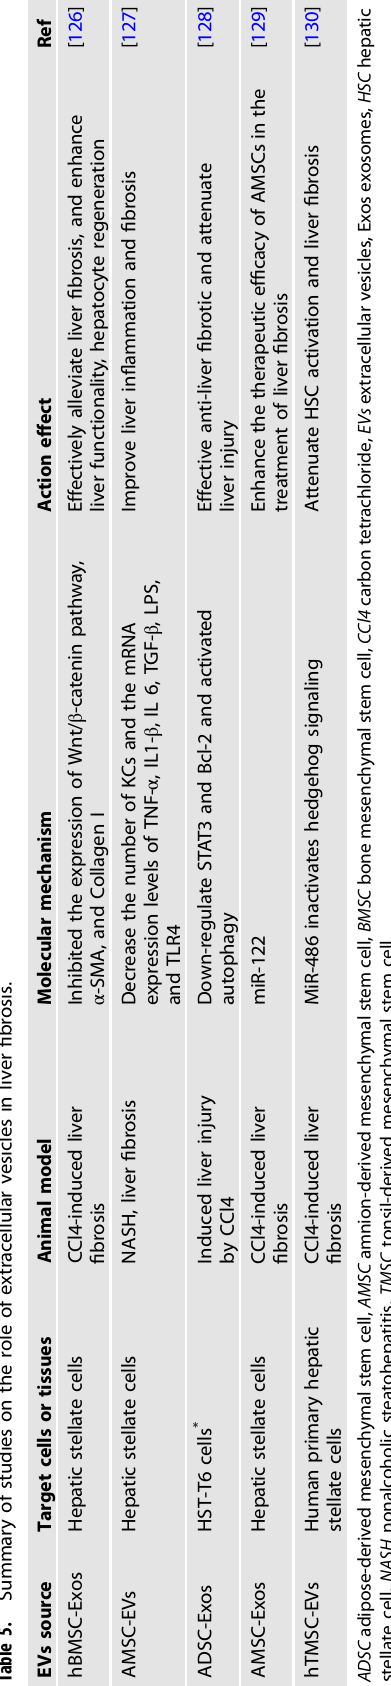
most tumors and is considered a tumor-like disease [142]. Recently, MSC-EVs have become an effective treatment for pulmonary fi brosis (Table 7). BMSC-Exos exert their therapeutic effect through immunomo- dulation. In a mouse model, BMSC-Exos have been shown to signi fi cantly ameliorate hyperoxia (HYRX)-induced bronchopul- monary dysplasia (BPD), alveolar fi brosis, and pulmonary vascular remodeling by suppressing M1 macrophage production and enhancing M2 macrophage generation [144]. Likewise, BMSC- Exos have been shown to signi fi cantly reverse fi brosis in a bleomycin-induced pulmonary fi brosis model by regulating total lung imbalance of M Φ phenotype [145]. In addition, the Wnt5a/ BMP signaling pathway regulated by UC-MSC-Exos can enhance Wnt5a, Wnt11, BMPR2, BMP4, and BMP9 expression, and down- regulate that of β -catenin, Cyclin D1 and TGF- β 1. In a monocrota- line (MCT)-induced rat model of pulmonary hypertension (PH), MSC-Exos were shown to signi fi cantly ameliorate pulmonary vascular remodeling and pulmonary fi brosis [146]. Of interest, Chaubey et al. showed that UC-MSC-Exos played a therapeutic role in improving pulmonary in fl ammation, pulmonary simpli fi ca- tion, pulmonary hypertension, and right ventricular hypertrophy through immunomodulatory glycoprotein TSG-6 in a neonatal BPD mouse model [147]. Additionally, MSC-EVs can reverse lung injury and pulmonary fi brosis by expressing in fl uential miRNAs. Wan et al. determined that high expression of miR-29b-3p by BMSC-EVs ameliorated IPF by FZD6 [148]. Zhou et al. found that miR-186 enriched by BMSC- EVs repressed the expression of SOX4 and Dickkopf-1 (Dkk1), thereby effectively inhibiting fi broblast development and attenu- ating IPF [149]. In addition, Lei ’ s study revealed that hPMSC -EVs could carry miR-214-3p and downregulate ATM/P53/P21 signaling, thus relieving radiation-induced lung in fl ammation and fi brosis [150]. In BLM-induced lung fi brosis and a mouse model of alveolar epithelial cell damage, exosomes secreted from MenSCs (MenSCs- Exos) have been shown to ameliorate pulmonary fi brosis by transferring miRNA Let-7 to suppress reactive oxygen species (ROS), mitochondrial DNA (mtDNA) damage, and activation of NLRP3 in fl ammasome [151]. Similarly, Xiao et al. used another LPS- induced Acute Lung Injury (ALI) mouse model and demonstrated that MSC-Exos repressed NF- κ B and hedgehog pathways by transporting miR-23a-3p and miR-182-5p, thereby improving lung injury and fi brosis [152]. CHALLENGES AND APPLICATION OF MSC-EVS AS AN ADVANCED THERAPY Although MSC-EV-based therapy holds great promise as a novel “ cell-free ” therapeutic product, there remain many challenges to overcome prior to their clinical application. At present, several limitations restrict the clinical translation of MSC-EVs including the discrepancies in the components of EVs from various sources and the lack of standard operation processes for largescale production, both of which largely depend on quality control of the sources of EVs. It is plausible to overcome these hurdles by introducing a strategy to control the quality of MSCs from the original source of EVs. The quality of MSC-derived EVs from different groups and batches is heterogeneous MSCs are most commonly derived from bone marrow, fat, umbilical cord and other tissues, but maintaining consistent quality of MSCs and their EVs from different sources and across batches is dif fi cult. This severely restricts the quality control and management of MSCs and their EVs as drugs, and increases the problem of drug resistance [153]. This results in limited reproducibility of functional measurements in vitro and in vivo